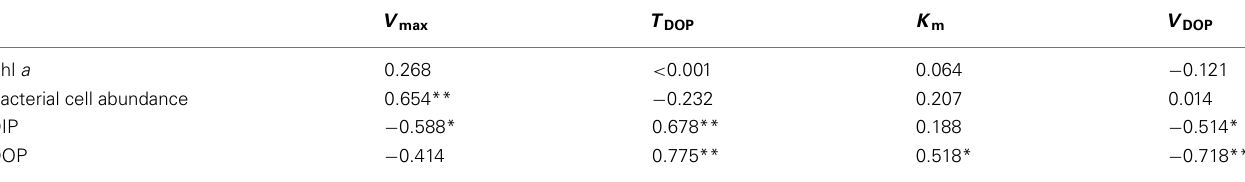
Table 2 | Correlation coefficients ( ρ ) from Spearman’s rank-order correlation analysis between chemical and biological variables of seawater and APA kinetic parameters in the phosphate-depleted euphotic zone (20–150m) of offshore stationsA, B, and C in the western North Pacific Ocean ( n = 15). V max T DOP K m V DOP Chl a 0.268 < 0.001 0.064 − 0.121 Bacterial cell abundance 0.654** − 0.232 DIP − 0.588* DOP − 0.414 Negative values for ρ indicate a negative correlation. Significant correlations of P < 0.05 and P < 0.01 are indicated by * and **,